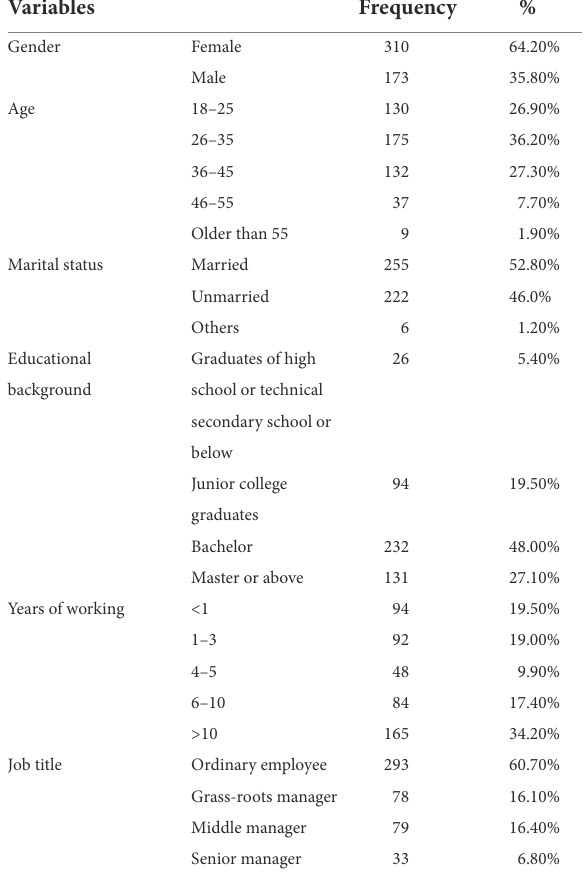
TABLE 1 Demographic characteristics ( N =